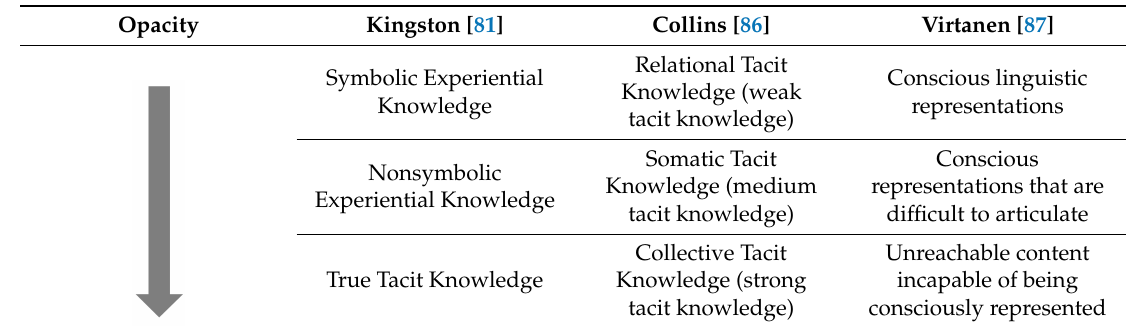
Table 2. Mappings of tacit